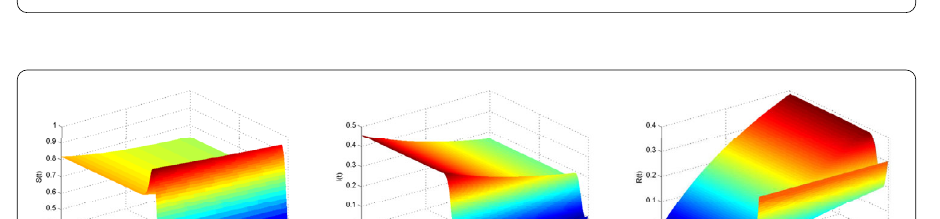
Figure 5 The effect of partial immunity on compartment I : ( a ) model (2) and ( b ) model (3)